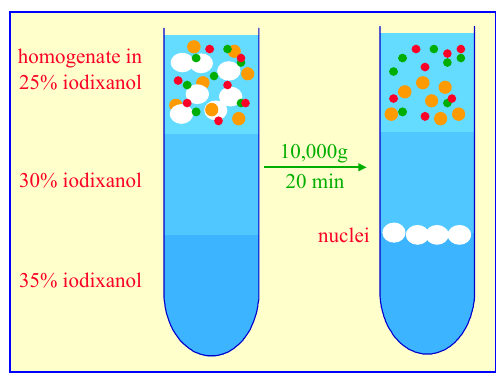
FIGURE 1. Purification of nuclei in a discontinuous iodixanol gradient.